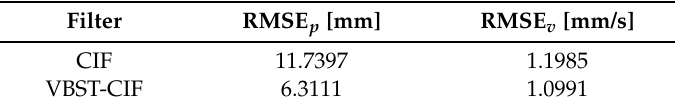
Figure 13. Position and velocity RMSEs. Table 3. MRMSEs in the experimental case